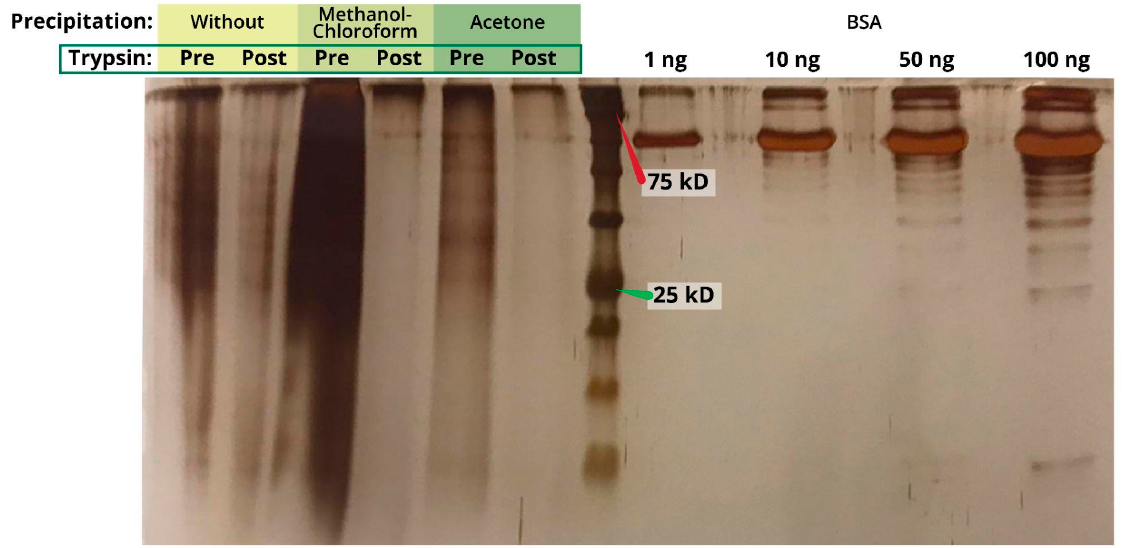
Figure 2. Silver ‐ staining of proteins separated on an SDS ‐ PAGE gel following either of two methods precipitation. Methanol-chloroform and acetone precipitation products before and after trypsinization of precipitation. Methanol ‐ chloroform and acetone precipitation products before and after trypsini ‐ zation of the 25% AA protein samples are shown. of the 25% AA protein samples are